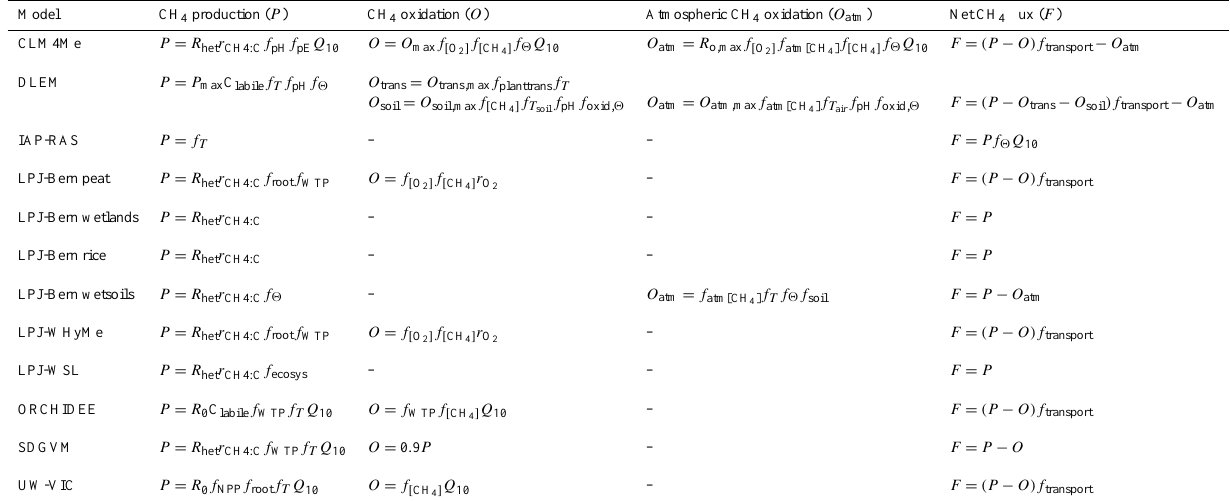
Table 5. A general description of the dependencies of CH 4 production, CH 4 oxidation (does not include atmospheric CH 4 oxidation) and CH 4 flux. All of the fluxes are modulated by a CH 4 -producing area (see Fig. 6). Parameters and variables used in the models were harmonized where possible, but identical names do not indicate identical values in the different